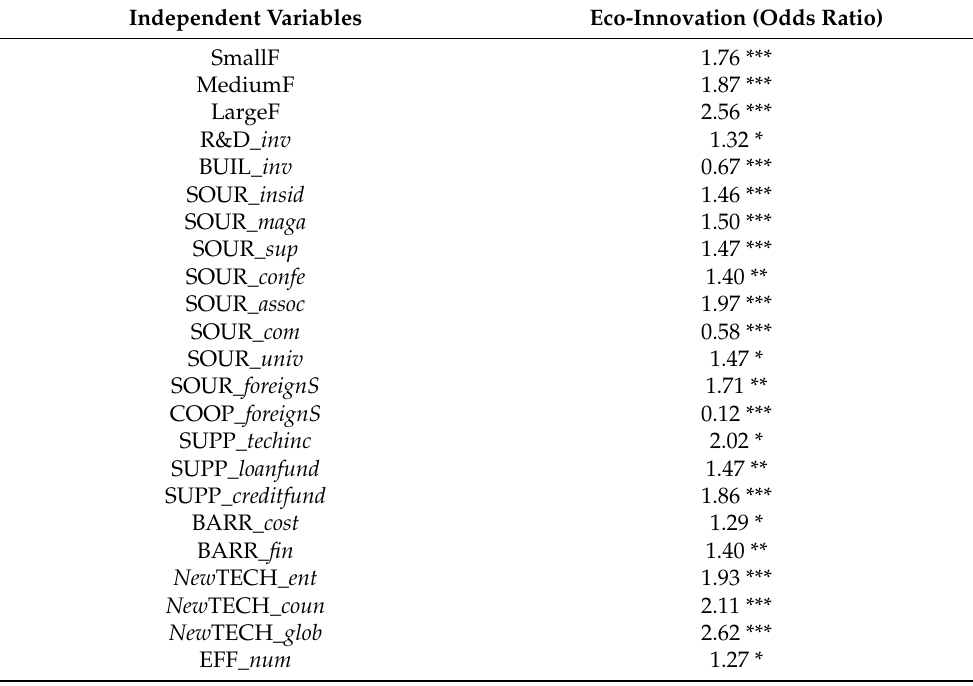
Table 5. Determinants for eco-innovation in the Polish Industry sector in 2013–2018, logit